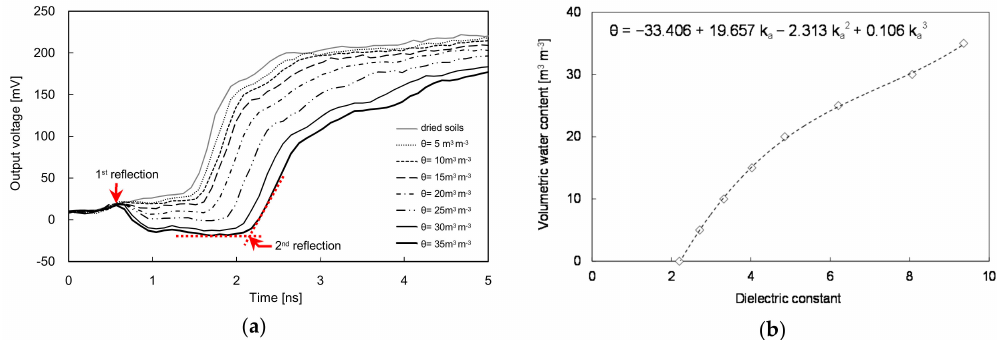
Figure 5. Calibration using soils sampled at Ny-Alesund, Svalbard: ( a ) TDR waveforms; ( b ) correlation between the dielectric constant and volumetric water content.